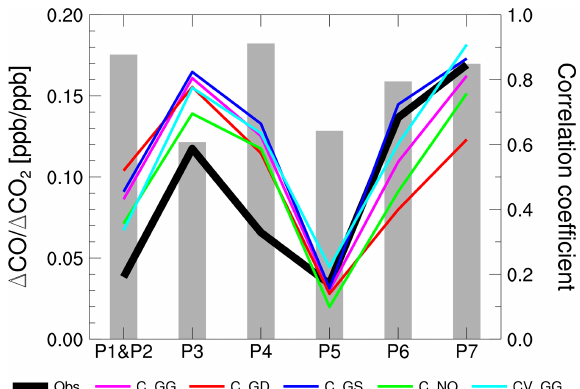
Figure 13. Observed and simulated enhancement ratios of (cid:49) CO /(cid:49) CO 2 (solid line) and observed correlation coefficients be- tween (cid:49) CO and (cid:49) CO 2 (grey bar) for each elevated mole fraction event defined by Figs. 5 and 6. The observed enhancement ratios are coloured in black. The simulated values were derived from pos- terior CO and CO 2 fluxes of C_GG (magenta), C_GD (red), C_GS (blue), C_NO (green) and CV_GG